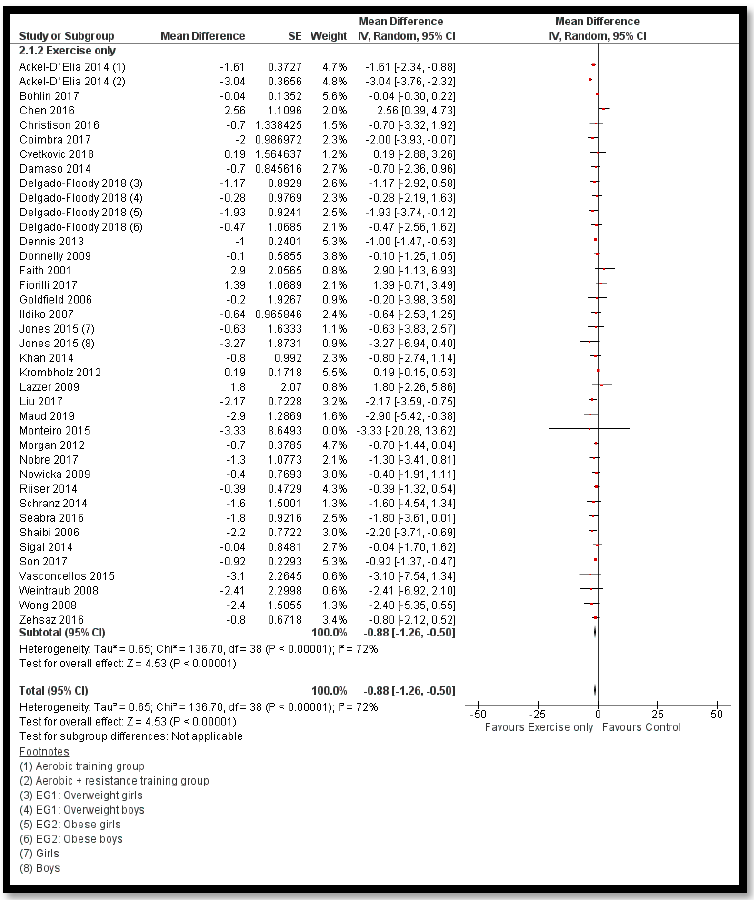
Figure 8. Forest plot for the effect of exercise only interventions for obesity management on body mass index (BMI) z -score .